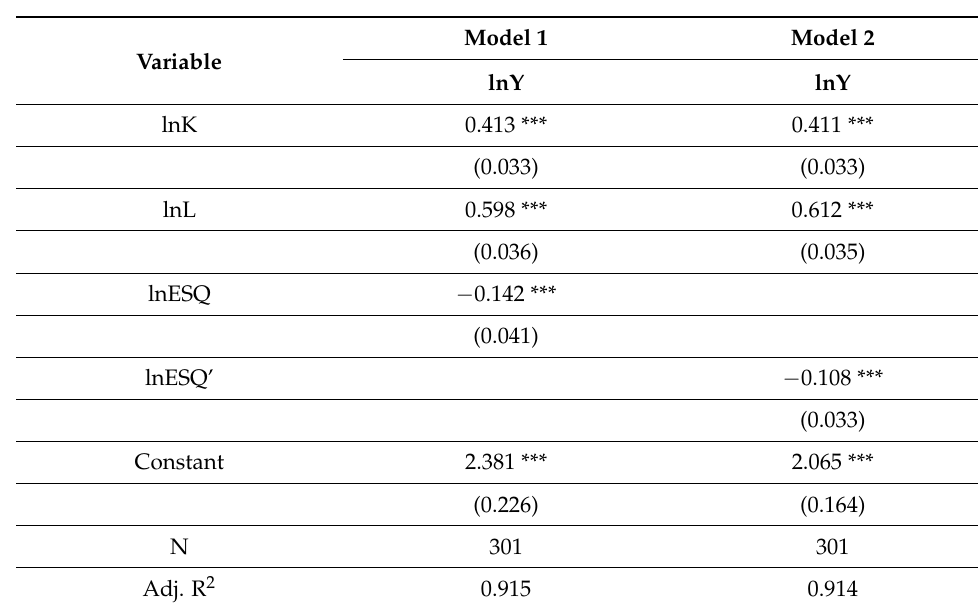
Figure 4. Within-province inequality of ESQ distribution: ( a ) Population-based Gini coefficients of SAIFI. ( b ) GDP-based Gini coefficients of SAIFI. Table 3. Estimation